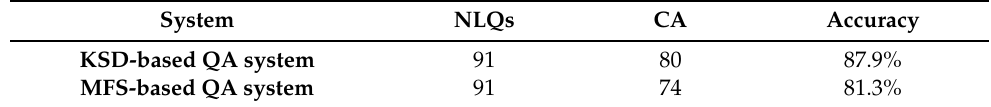
Table 3. Results of the evaluation includes system, number of questions (NLQs), correctly answered (CA) questions and